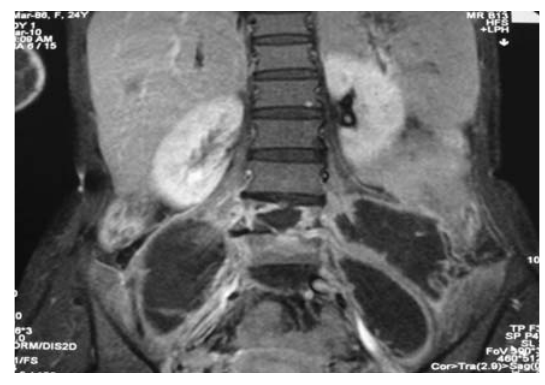
Figure 2. Post contrast TIW coronal MR image shows peripherally enhancing lesion in bilateral psoas muscle suggestive of psoas abscess.